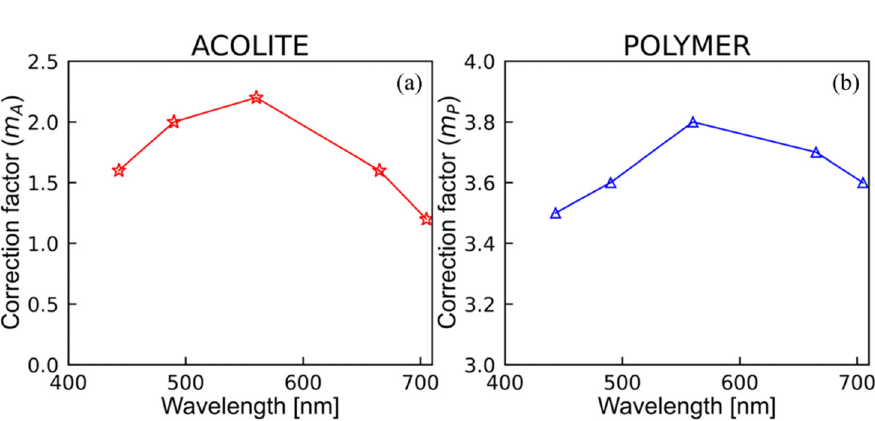
Figure A1. The tuned correction coefficients m A (ACOLITE) ( a ) and m P (POLYMER) ( b ) that were used to correct for the difference between the satellite ( ρ w ) and modelled reflectance R e